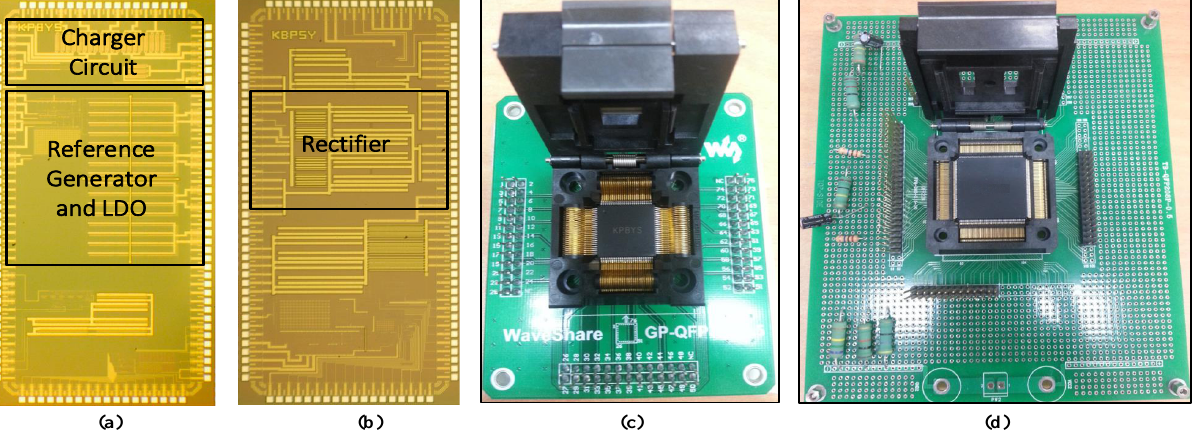
Figure 16. ( a ) Die-micrograph of the fabricated LDO and charger circuit; ( b ) die-micrograph of the fabricated rectifier; ( c,d ) packaged chip mounted on to the socket for